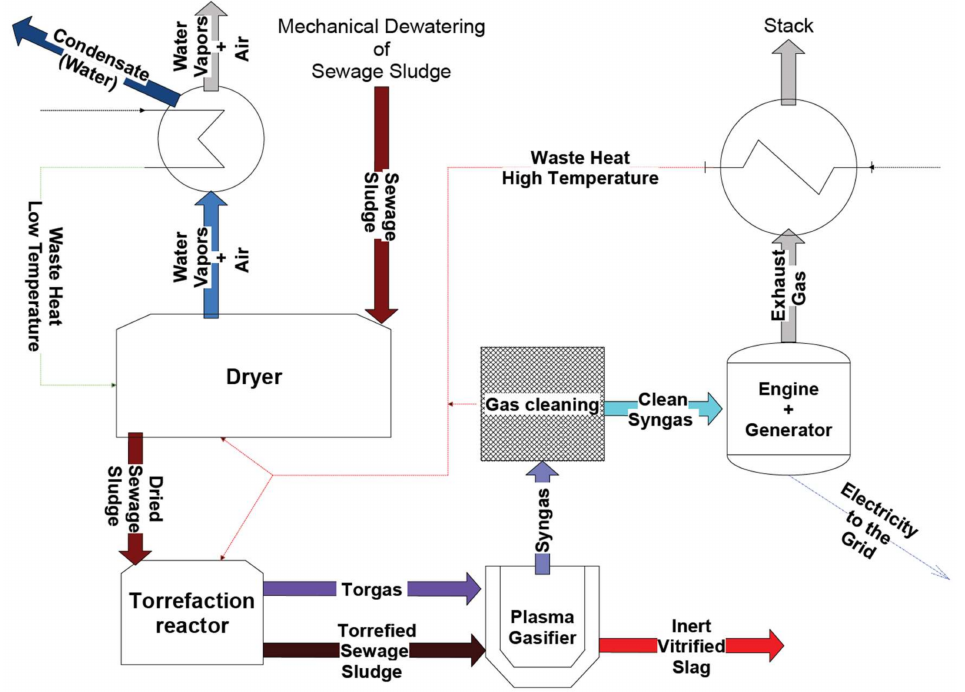
Figure 5. Diagram of the novel installation for utilization of sewage